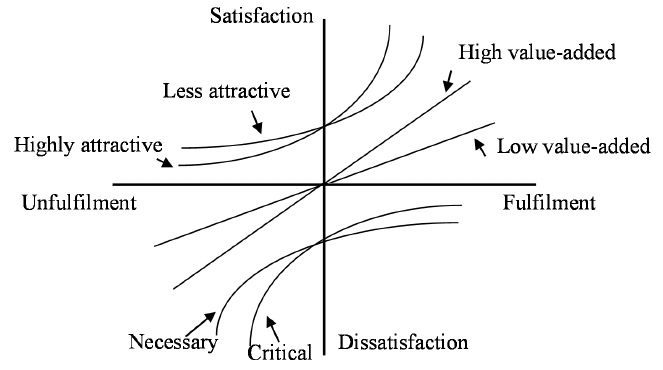
Figure 1. The refined Kano model.